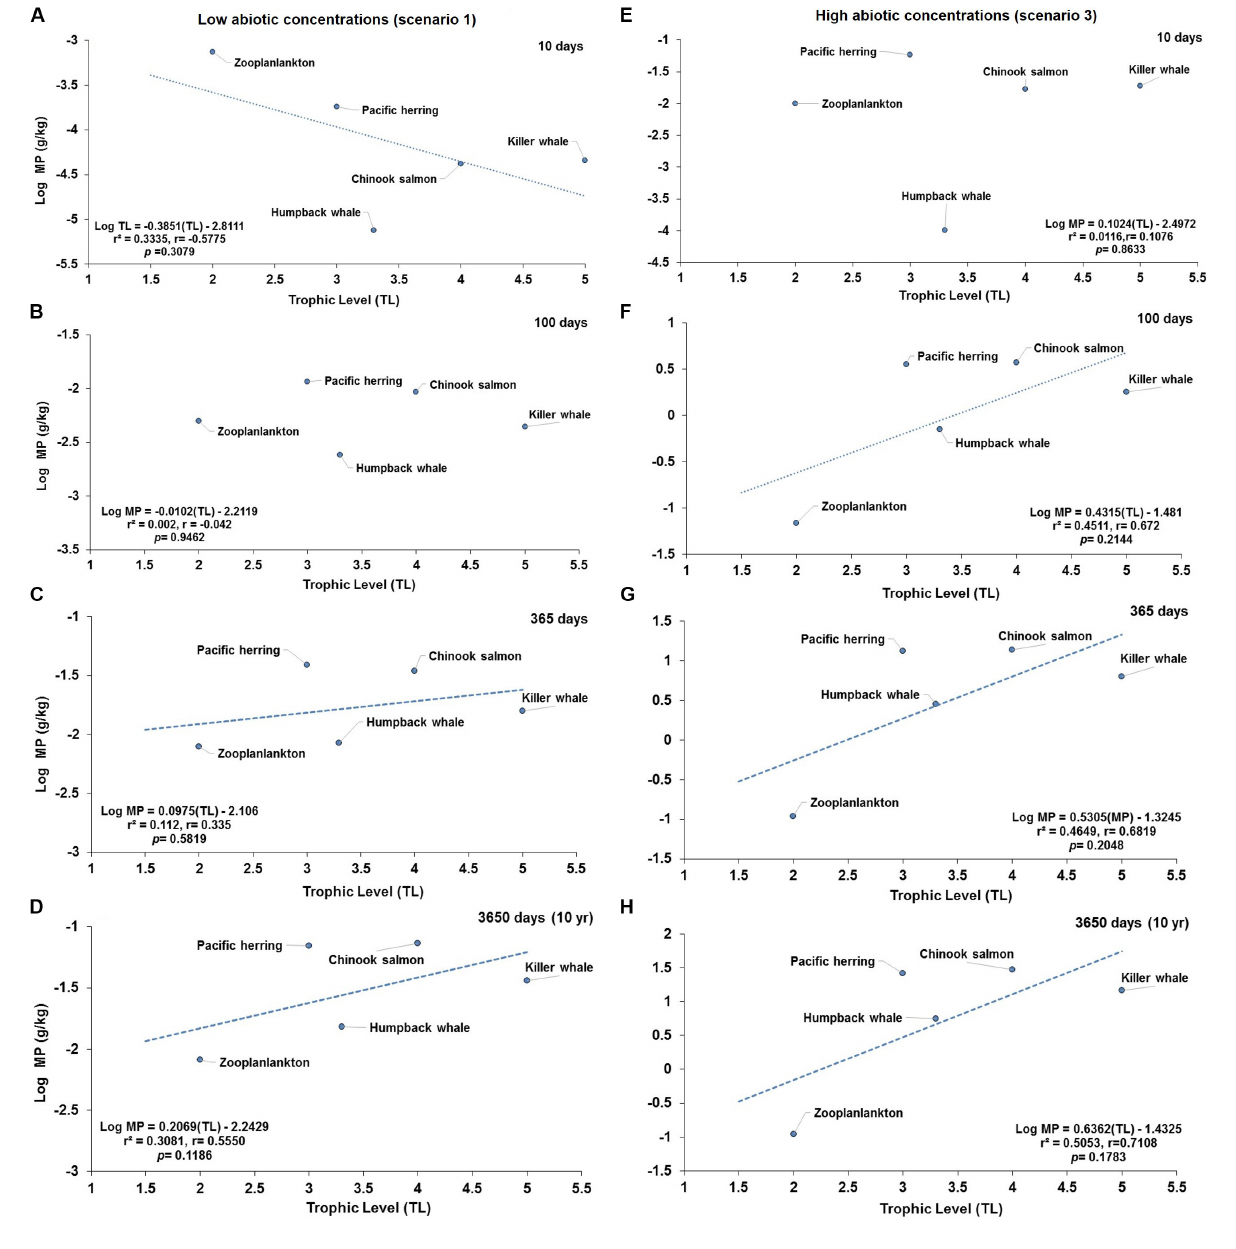
FIGURE 6 | Projections of predicted concentration of microplastics (MPs) versus trophic levels (TL) in a simplified cetacean food web of the Northeastern Pacific for simulations under low (scenario 1) and higher (scenario 3) abiotic concentrations. Scenario 1 (i.e., seawater = [0.003 g/L]; and, sediment = [0.266 g/kg dw]) at (A) 10 d (no significant, negative relationship); (B) 100 d (lack of relationship); (C) 365 days (no significant, positive trend), and (D) 3650 days (no significant, positive trend). Scenario 3 (i.e., water = [0.040 g/L]; and, sediment = [111 g/kg dw]) at (E) 10 days (lack of relationship); (F) 100 days (no significant, positive relationship); (G) 365 days (no significant, positive relationship); and (H) 3650 days (no significant, positive relationship). The dotted lines indicate the direction of the slope showing the negative (A) and positive ( C,D , and from F–H )